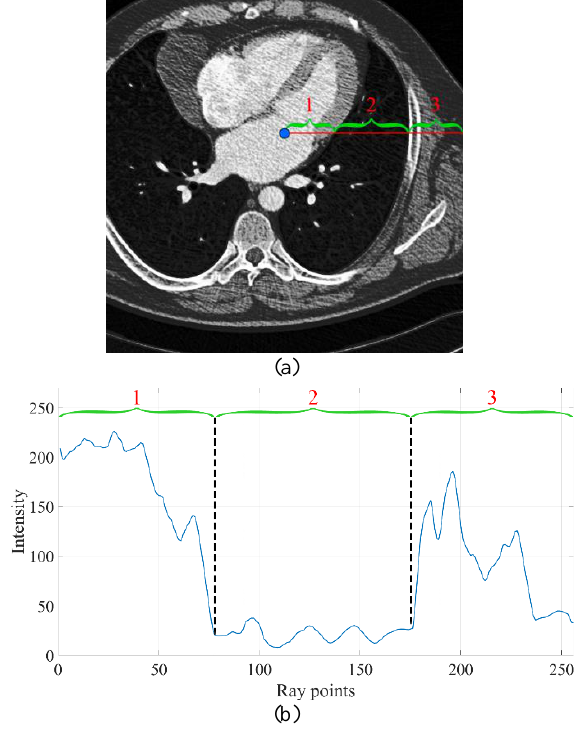
Figure 1. Data acquisition along the ray: an emitted ray (a) and its intensity profile (b)